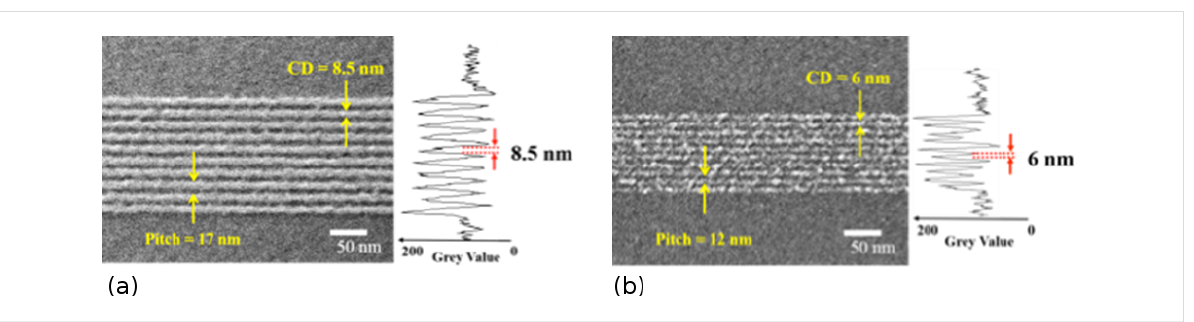
Figure 7: HIM image of dense (1:1) single-pixel features exposed at (a) 0.09 nC·cm − 1 and (b) at 0.04 nC·cm − 1 in ca. 10 nm thick HM-01A fullerene resist, with line scans of secondary electron intensity providing measurements of linewidth